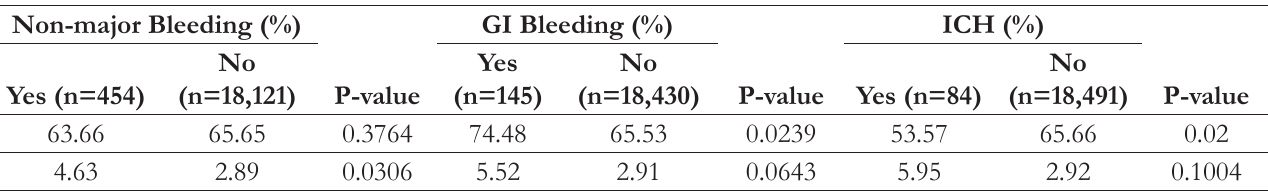
Table 6. Pharmacotherapy Patterns for Patients with Bleeding/Hemmorhagic Outcomes after AF Diagnosis Non-major Bleeding (%) P-valueYes